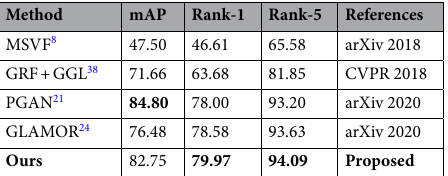
Table 6. The mAP, Rank-1 and Rank-5 on VRIC dataset (in %). Bold indicate the best results for the corresponding